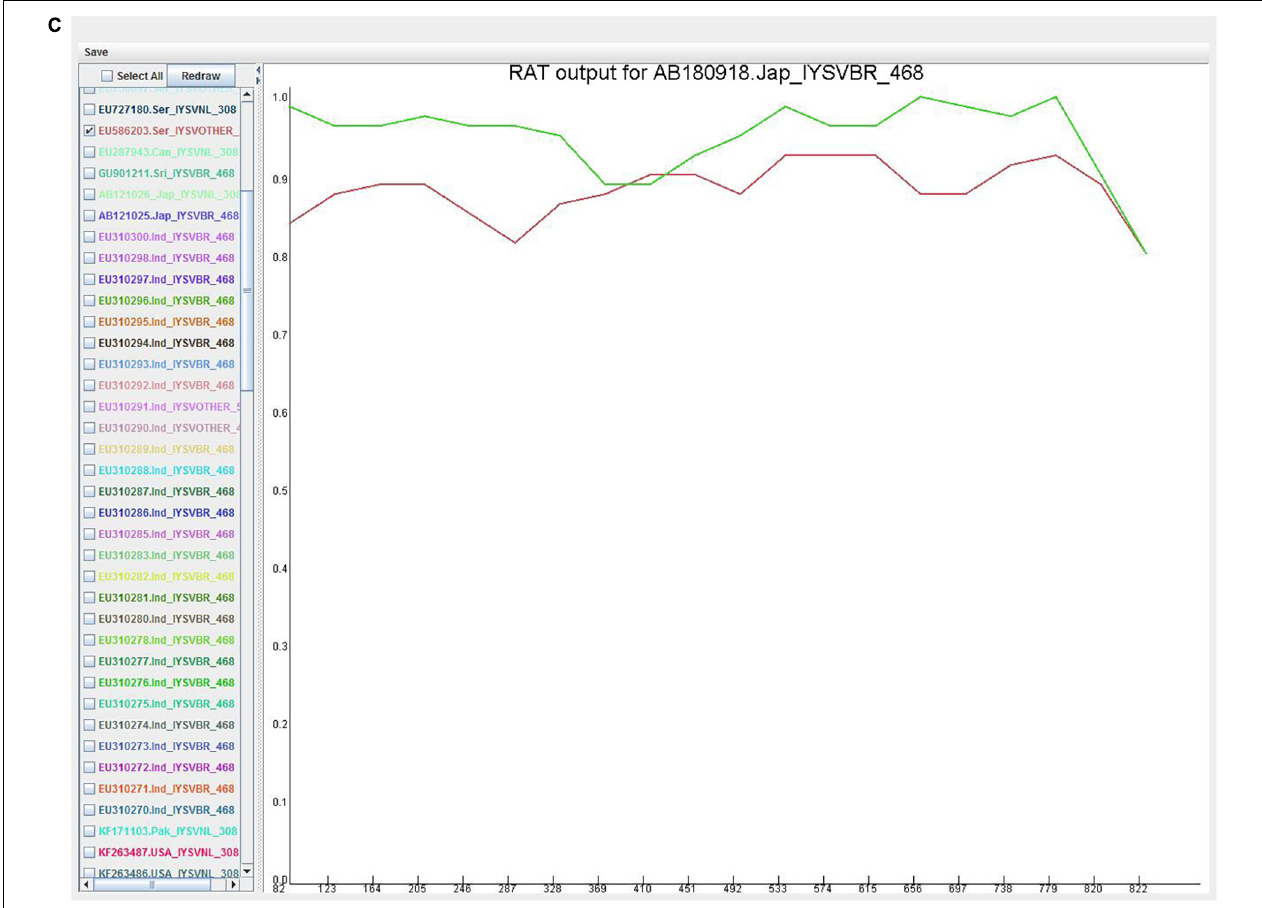
FIGURE 5 | Recombination cross over sites in the Iris yellow spot orthotospovirus nucleocapsid (N) gene generated by Recombination Analysis Tool. The X- axis denotes sequence location along the genome and Y -axis represents the genetic distance. (A) AF067070_Brazil, the crossover site is located at 3 (cid:48) end portion of the genome; (B) HQ148174_Iran, the crossover sites were located toward the 5 (cid:48) and 3 (cid:48) ends of the genome; (C) AB180918_Japan, the crossover site is located in the middle portion of the genome.